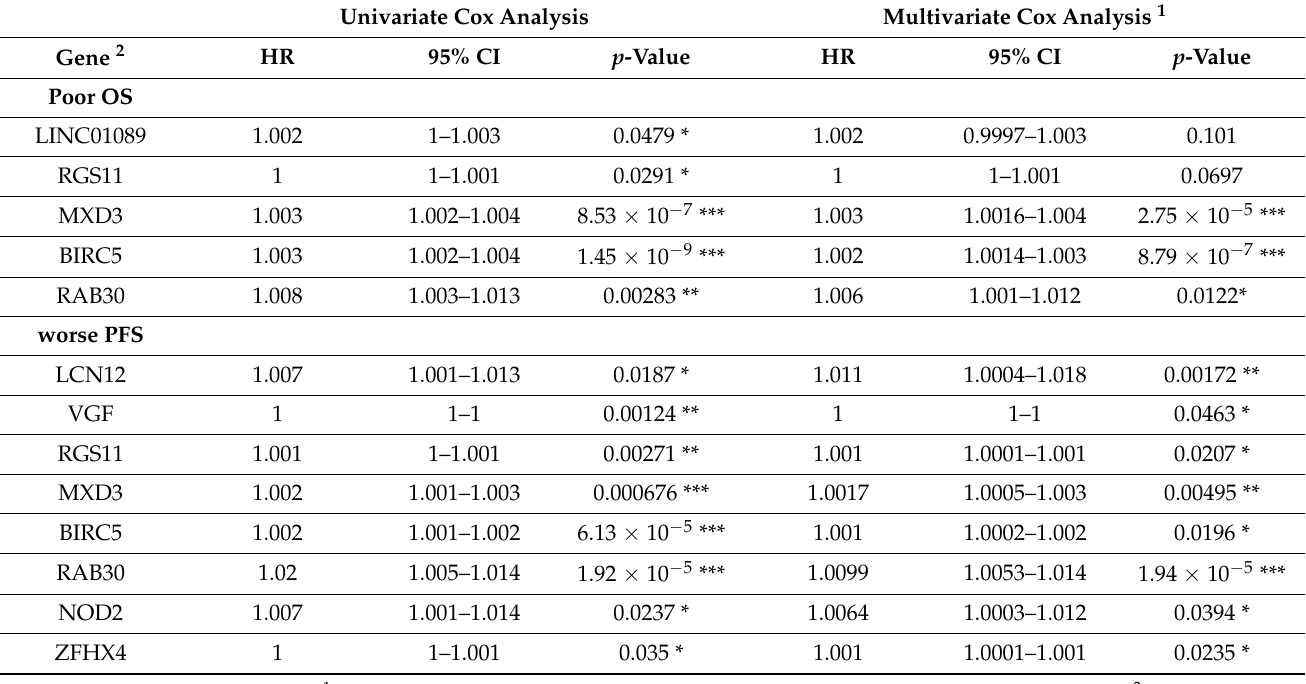
Table 1. Univariate and multivariate Cox analyses of Sig27var25 component genes in predicting ACC poor OS and progression.